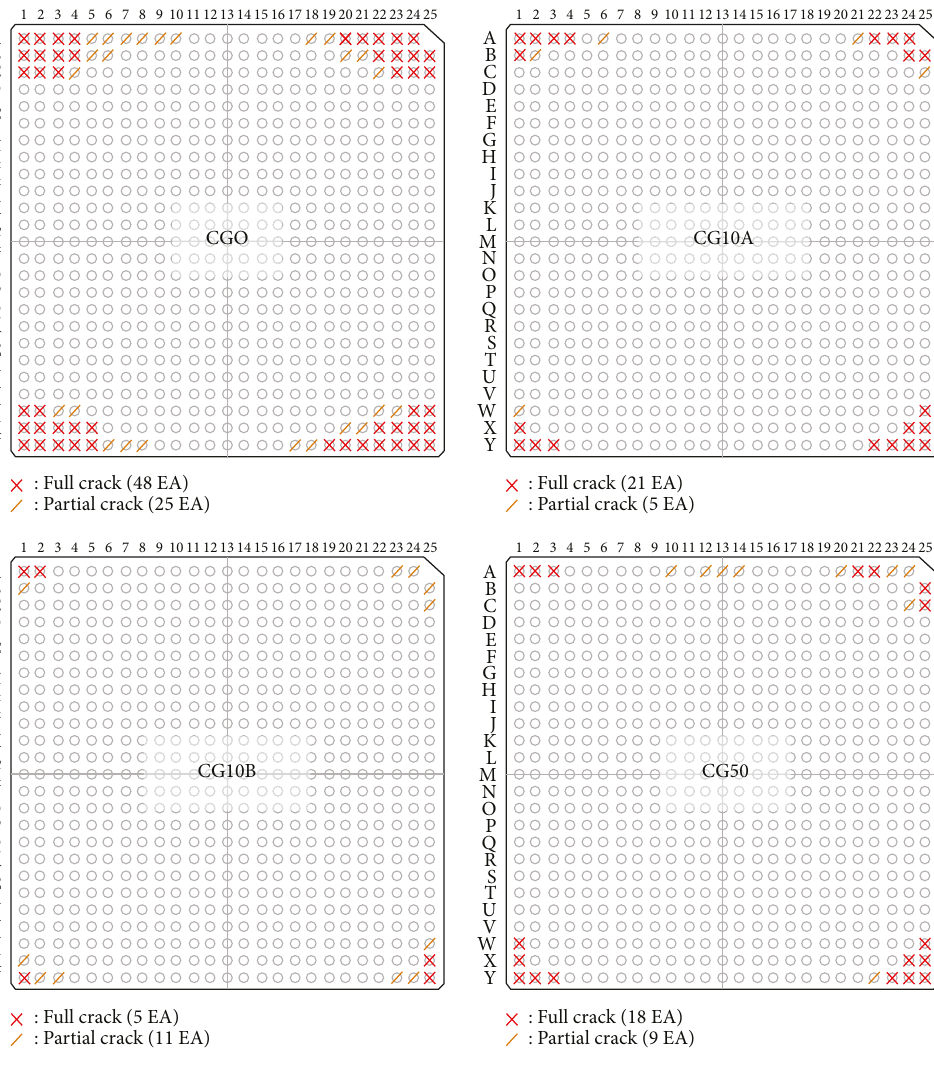
Figure 10: Location and number of cracked solder joints for each specimen.